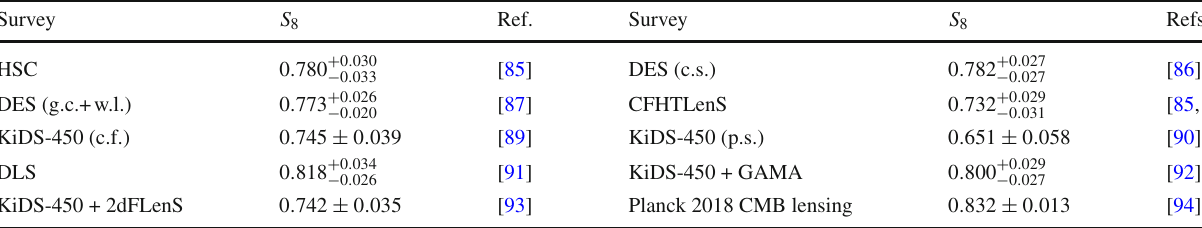
[86] 0 . 027 [85,88] 0 . 031